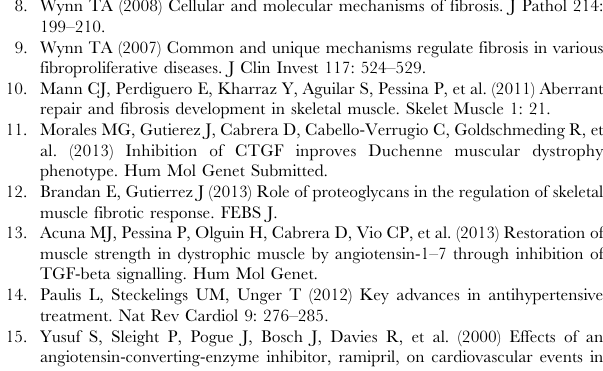
Figure S1 Functional expression of human ACE2 in HEK293T cells. (A) Kinetics of substrate cleavage by cell extracts of non-infected HEK293T cells (white squares), and cells infected with Ad-GFP (gray squares) or Ad-hACE2 (black squares). (B) Hydrolysis rate of 50 uM Mca-YVADAPK(Dnp) by HEK293T cell extracts. (C) Detection of ACE2, GFP, and tubulin in HEK293T cell extracts by western blotting. Each lane was loaded with 20 m g of cell extract from non-transduced (NT) cells or cells transduced with Ad-GFP or Ad-hACE2. Molecular weight standards are shown on the right. (TIF) Figure S2 ACE2 overexpression decreases fibronectin protein levels in dystrophic muscle. (A) Effect of augmented expression of ACE2 on fibrosis was determined by western blot analysis. TA mdx extracts were obtained 1, 3, and 5 days after injection with PBS, Ad-GFP, or Ad-hACE2. Each lane was loaded with 50 m g of muscle extract and immunodetection of ACE2, fibronectin (FN), and GAPDH (loading control) was performed. Molecular weight standards are shown on the right. (B) TA mdx muscle was injected with Ad-GFP or Ad-hACE2 adenoviral vectors and analyzed after 1 or 5 days by ACE2 immunodetection. ACE2 expression was evident 5 days post-injection (Bar 200 um).